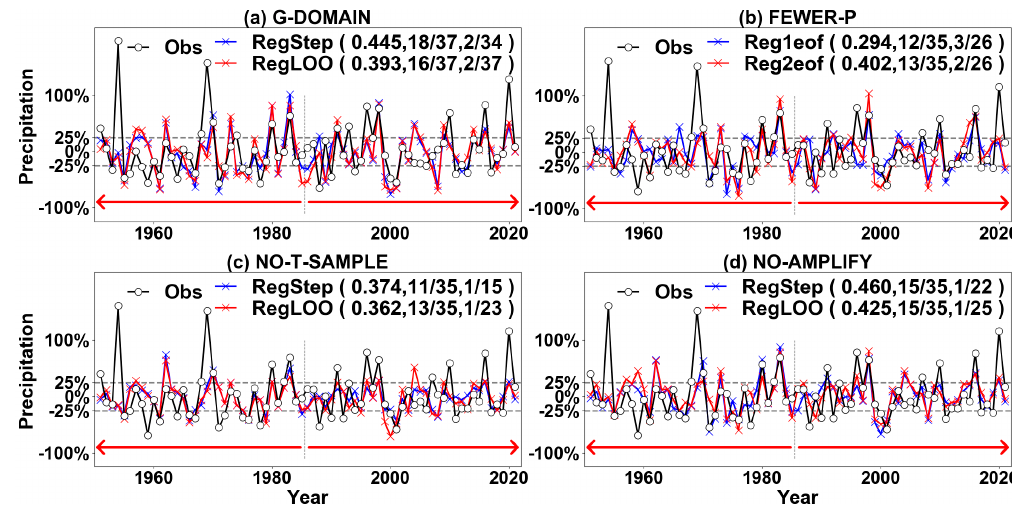
Figure 4. Similar to Figure 3, but for sensitivity experiments. The experiment name is shown at the top of each graph. top of each